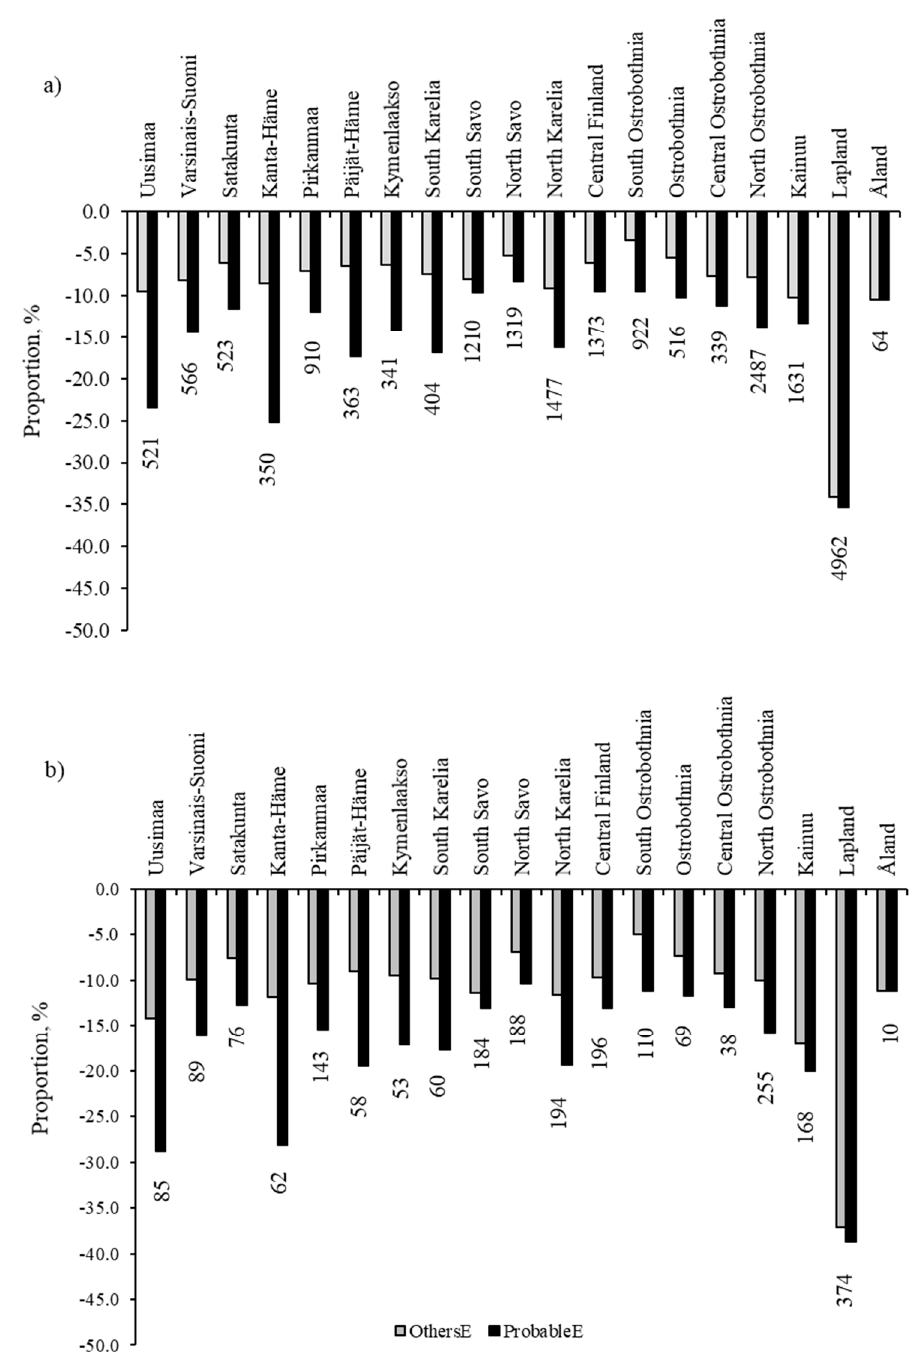
Figure 2. The proportion of ( a ) area with restrictions on forest management and ( b ) volume of the growing stock in the areas with restrictions on forest management in OthersE and ProbableE in different provinces in Finland. The numbers below the bars represent the total area (million ha − 1 ) of forest land and the volume (million m − 3 ) of the growing stock in forest land in each province in 2016.